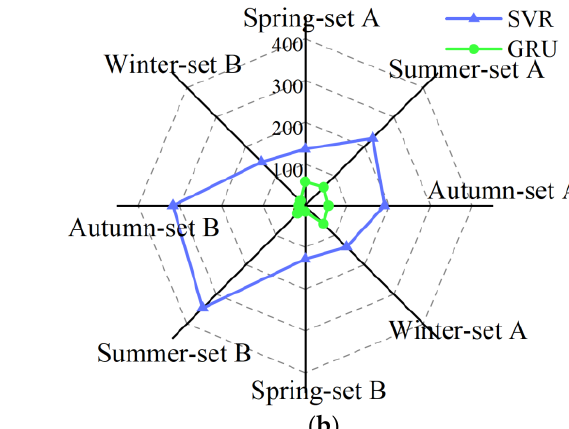
Figure 7. Point forecasting results of dataset B.